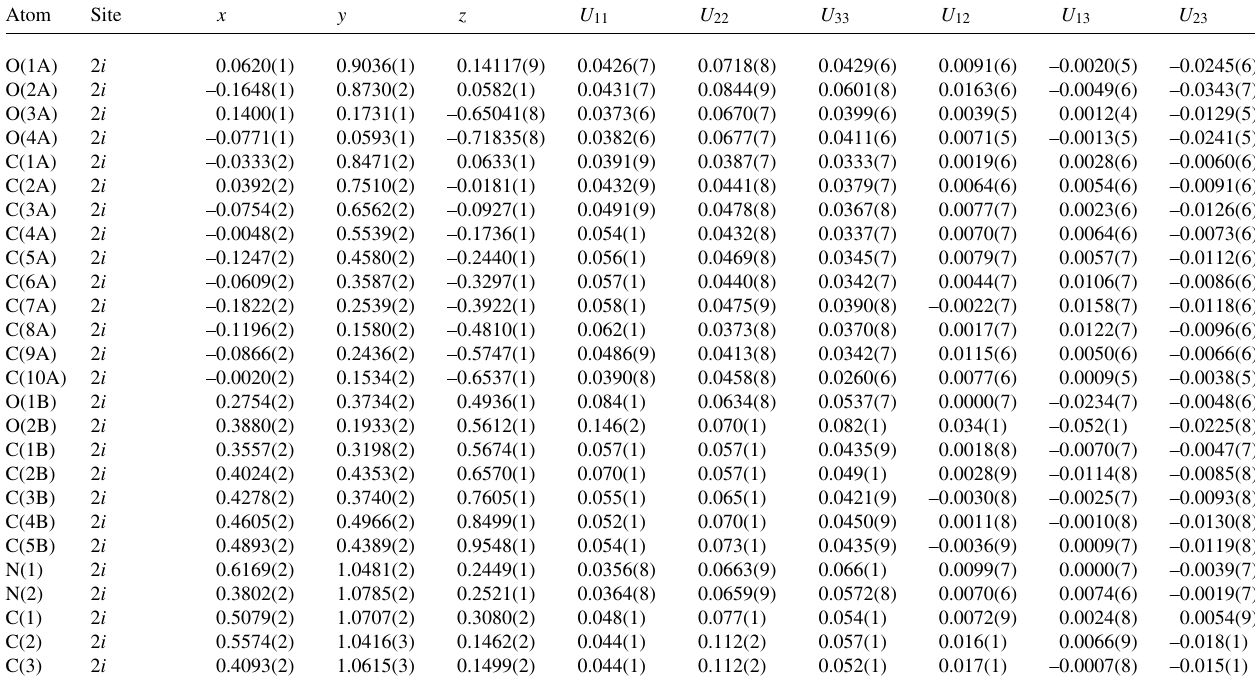
Table 3. Atomic coordinates and displacement parameters (in Å 2 ) .